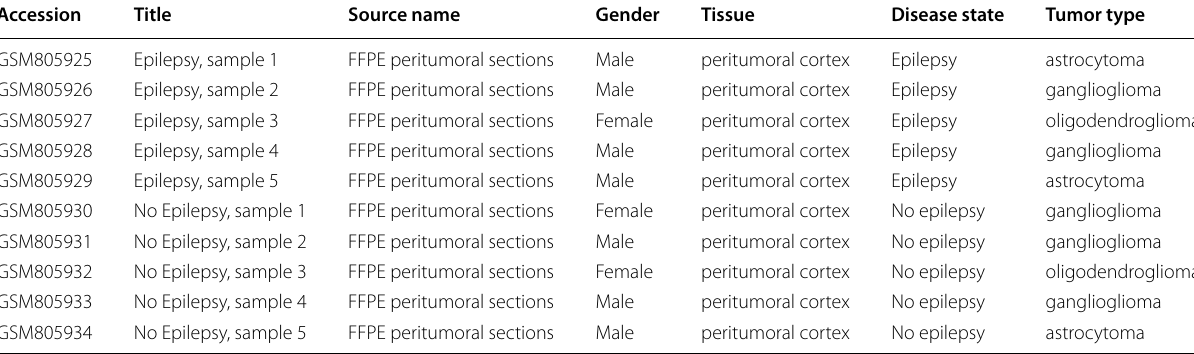
FFPE formalin-fixed paraffin-embedded